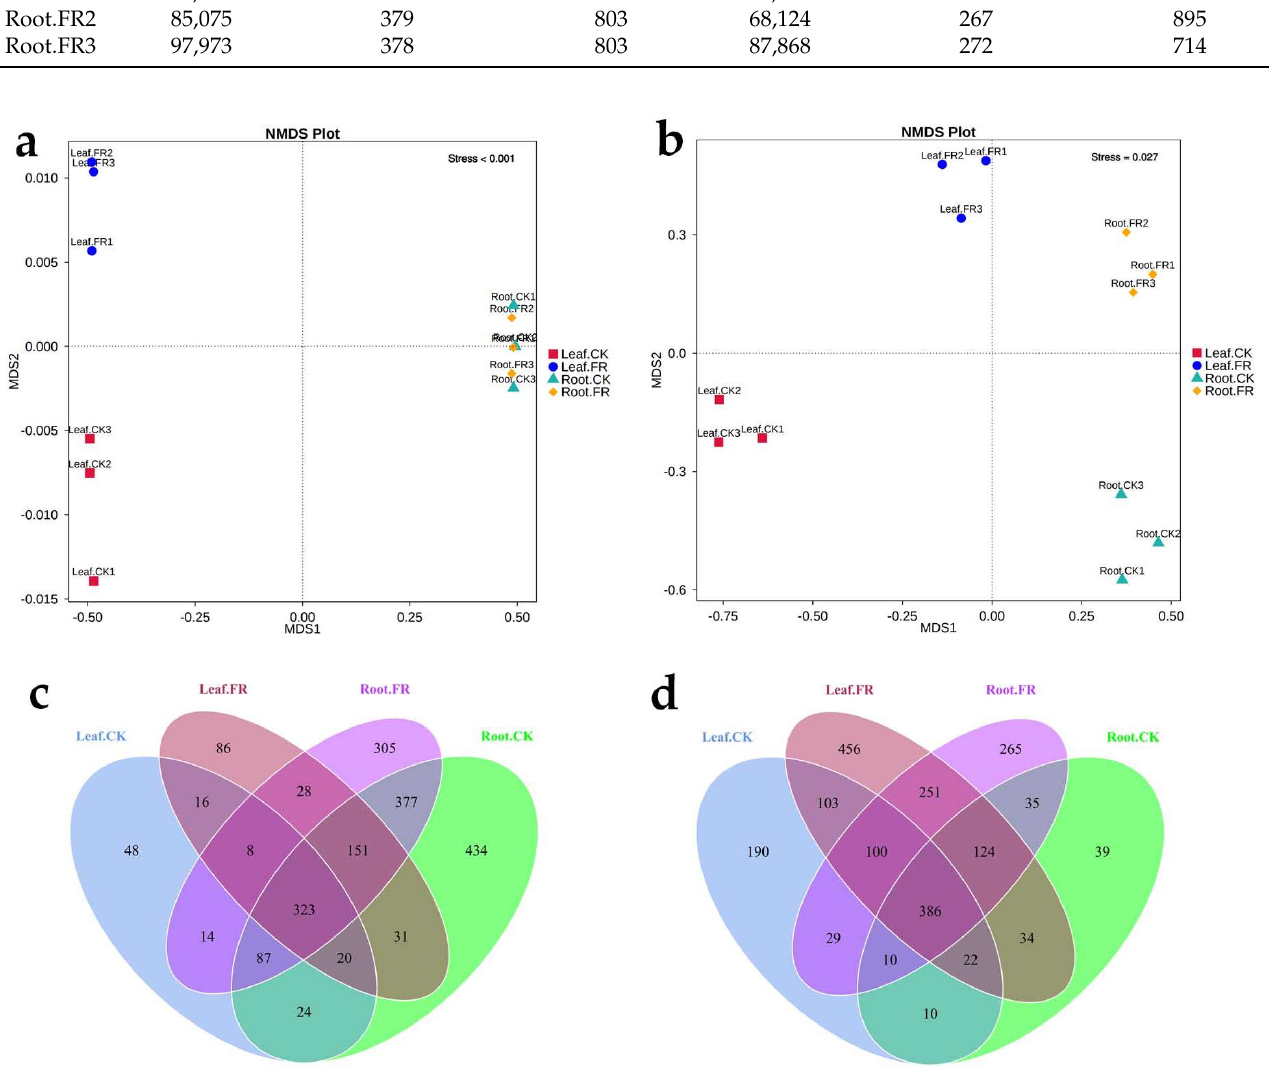
Figure 2. NMDS and Venn analysis of the endophytic bacteria and fungi in the leaves and roots of Leymus chinensis (LC) in the DARK (FR) and OUT (CK) zones of Leucocalocybe mongolica (LM) fairy rings. NMDS of the ( a ) bacterial and ( b ) fungal OTUs in the FR and CK leaves and roots. Venn analysis of the ( c ) bacterial and ( d ) fungal OTUs.